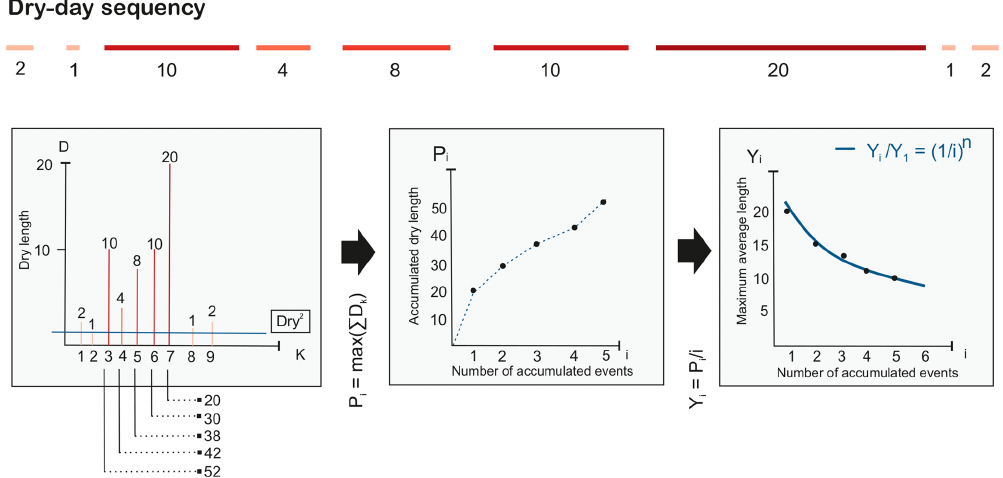
Figure A2. Method for defining DSS events and their corresponding n